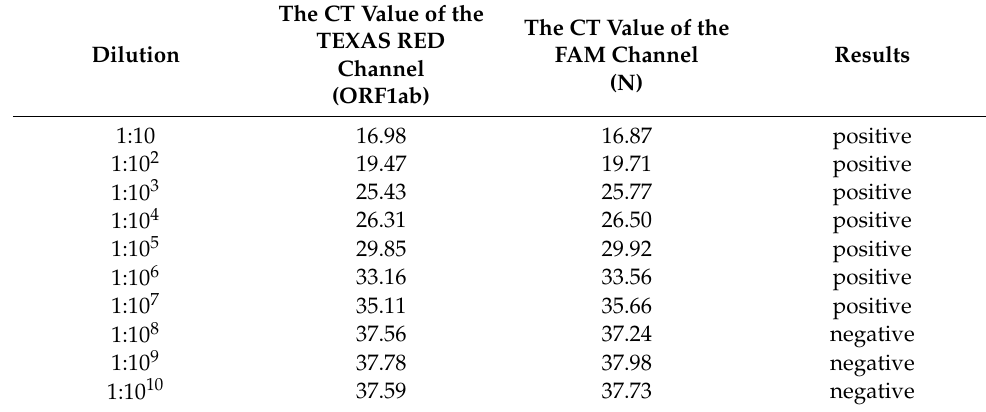
Table 4. Nucleic acid detection of cultures inactivated with different concentrations of SARS-CoV-2.